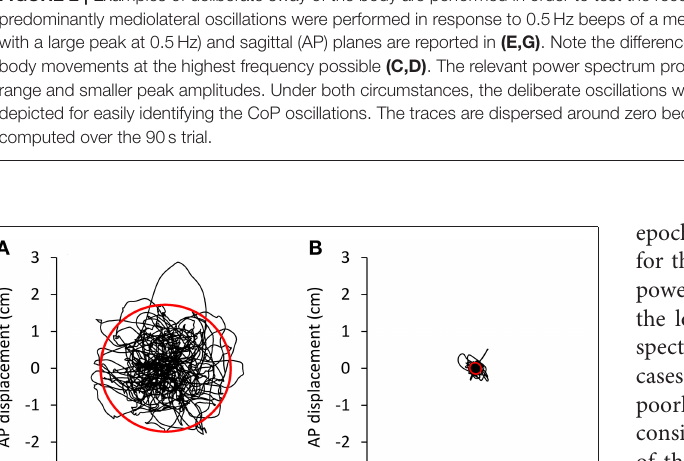
power spectra separately for the frontal (ML) and the sagittal (AP) planes. The local minima were identified in